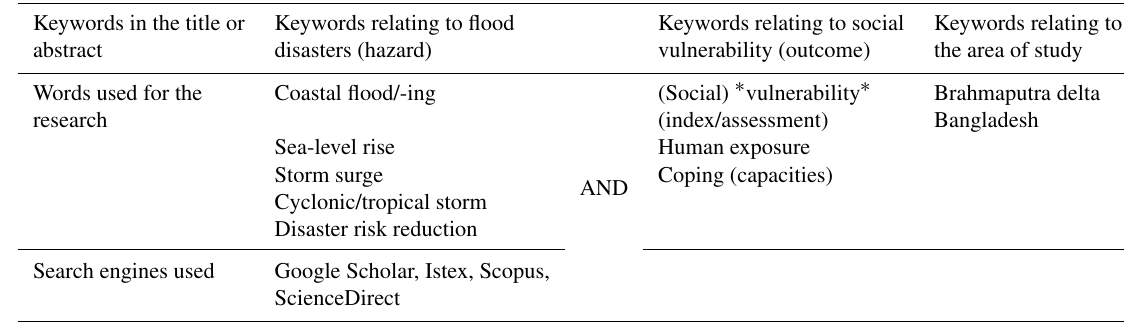
Table A1. Search strategy used to identify studies for inclusion (adapted from Alderman et al., 2012).